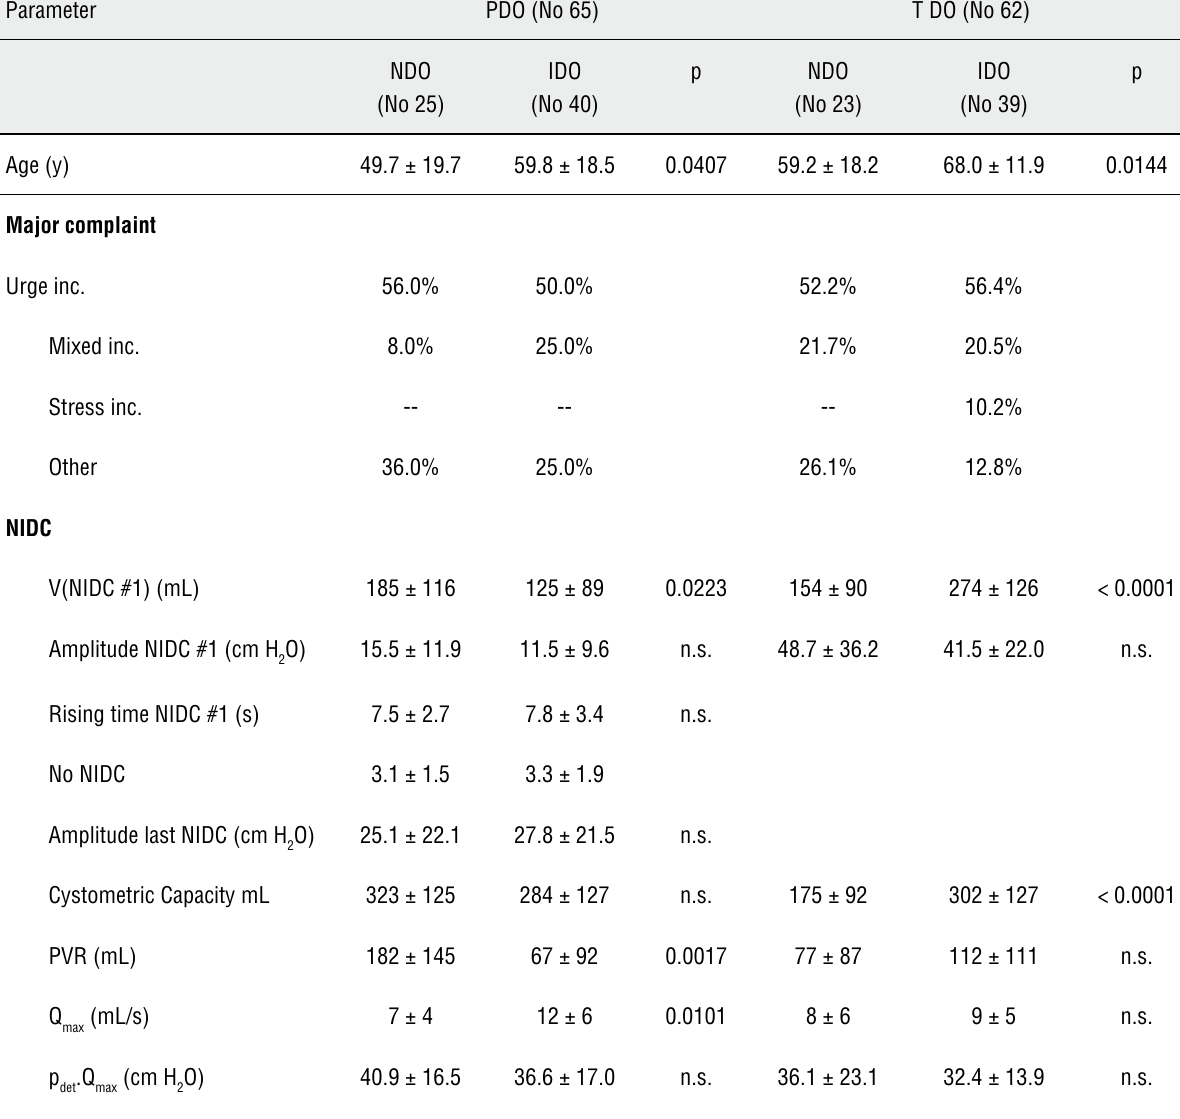
Table 3 - Demographic and urodynamic characteristics of the female population (PDO: phasic detrusor overactivity, TDO: terminal detrusor overactivity, NDO: neurogenic detrusor overactivity, IDO: idiopathic detrusor overactivity, NIDC non-inhibited